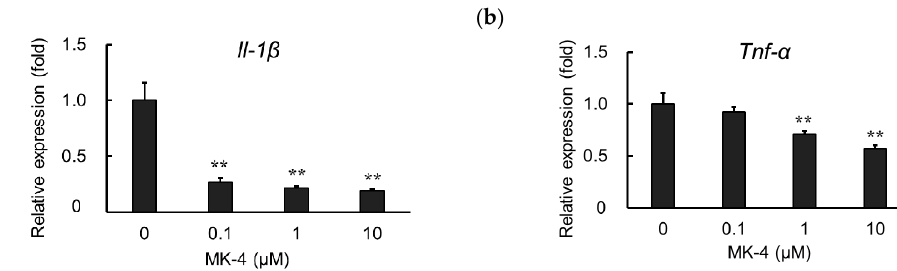
Figure 3. Menaquinone-4 (MK-4) suppresses inflammatory cytokine expression after TNF- α treatment. Various doses of MK-4 (0 ‒ 10 µM) were administered to MG6 cells for 24 h, and cells were subsequently exposed to TNF- α (10 ng/mL) for 3 h. The mRNA levels of Il-1 β and Tnf- α were measured by quantitative reverse transcriptase-PCR, normalized to levels of Eef1a1 (the internal standard), and expressed as the fold-change relative to control cell values (cells not treated with MK-4). ( a ) Il-1 β levels and ( b ) Tnf- α levels. Data are presented as the mean ± S.E.M, n = 3. Values were significantly different from those of the control at ** p < 0.01.